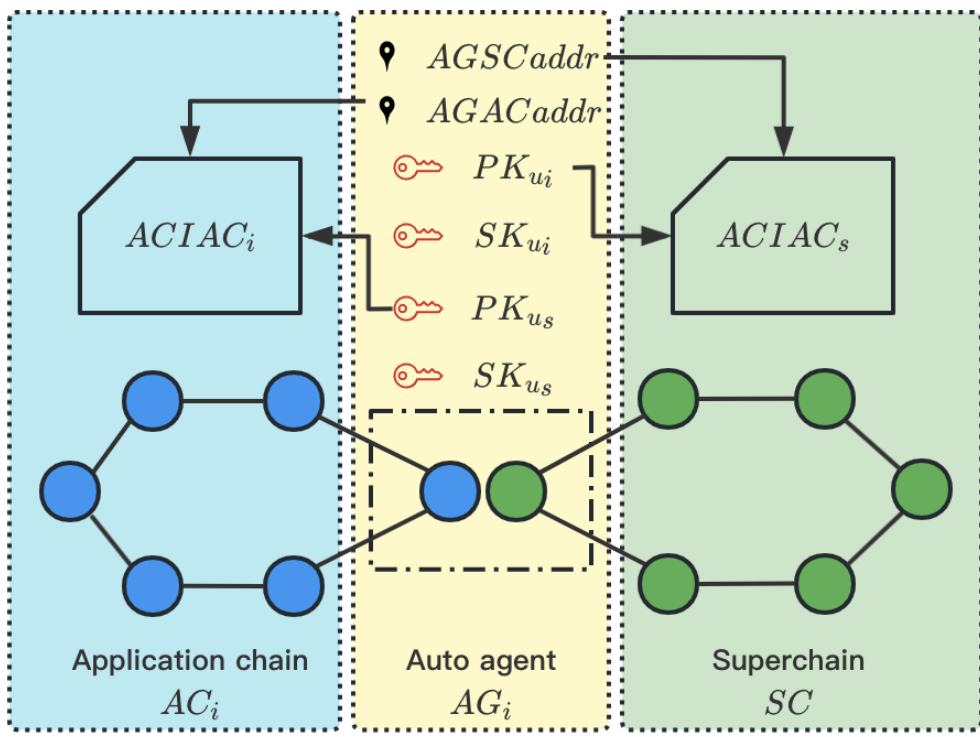
Figure 3. Chain Registration with Access Control and Identity